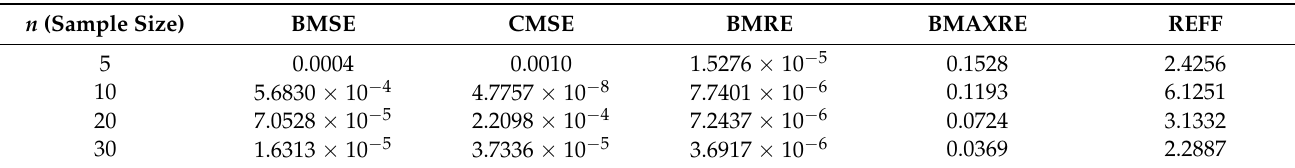
Table 5. Estimation efficiency: numerical results for case A1.